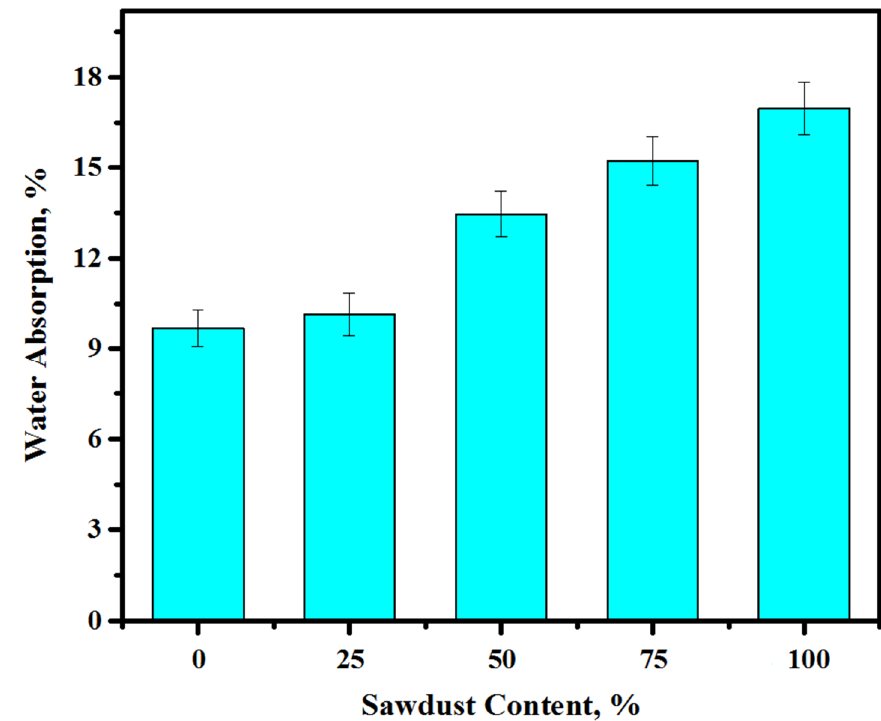
ff erent sawdust